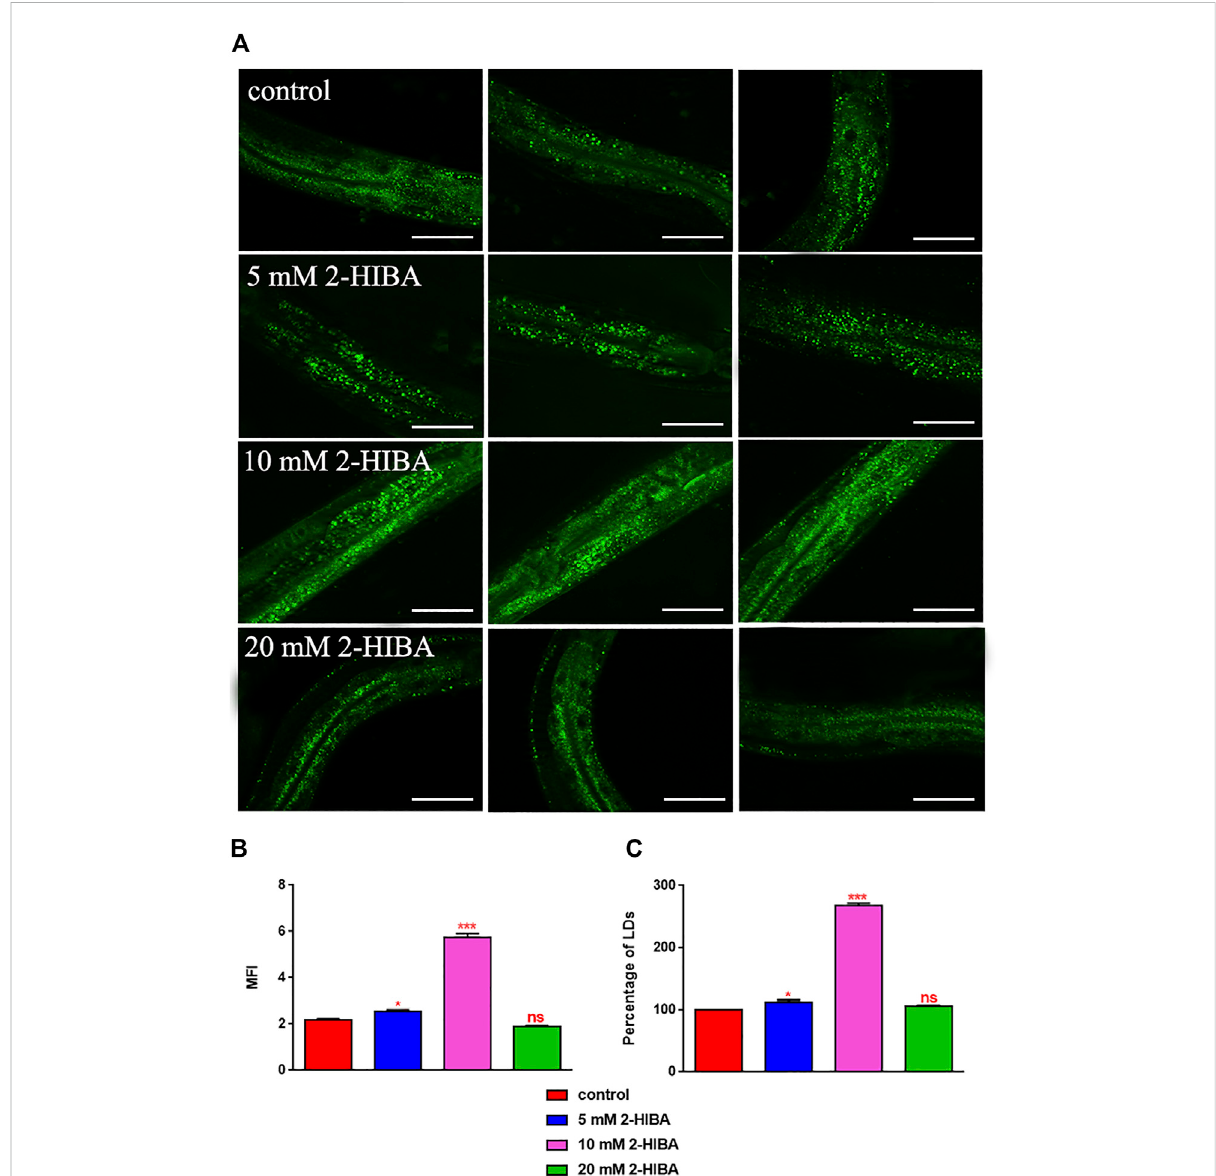
FIGURE 8 Visualization of lipid droplets. (A) BODIPY staining of 1 day adult worms treated or not with 5 mM, 10 mM or 20 mM 2-HIBA (control: untreated worms). Scale bar = 50 μ m. (B) Related Mean Fluorescence Intensity and (C) percentage of lipid droplets. Statistical analysis was evaluated by one- way ANOVA with the Bonferroni post-test; asterisks indicate signi fi cant differences (* p < 0.05, *** p < 0.001, ns: not signi fi cant). Bars represent the mean of three independent